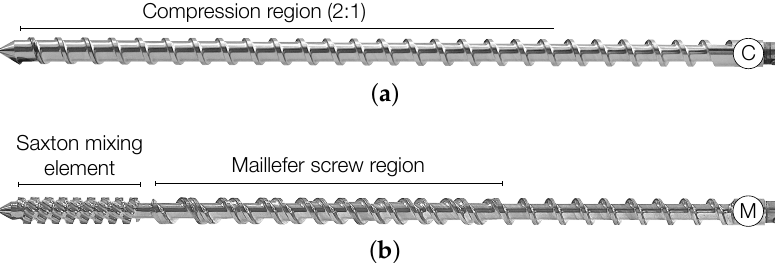
Figure 1. The screw types used to control the deformation history of the nanocomposites analyzed using a Brabender 19/25D single-screw extruder: ( a ) C-screw, conventional geometry with 2:1 compression ratio; and ( b ) M-screw, distributive mixing screw composed of a Maillefer region a Saxton mixing element.